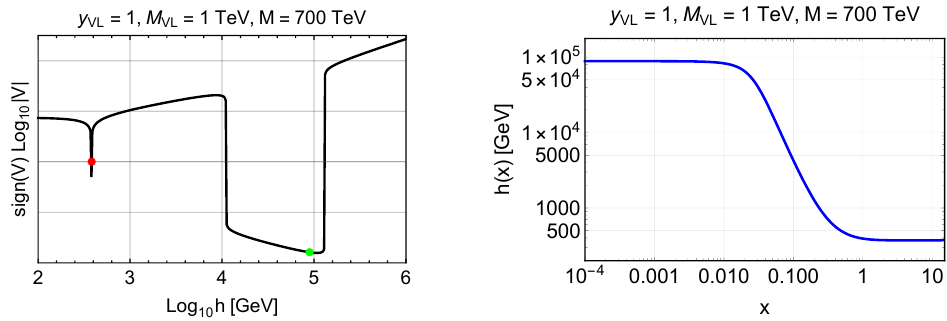
Figure 11 . Potential (left) with UV vacuum restored by a | H h | 6 /M 2 dimension-6 operator at a cut-off M = 700 TeV and the corresponding bounce solution (right) between the green and red points, calculated by solving numerically the Euclidean equation of motion for the Higgs field h as a function of the radial coordinate x , as described, e.g., in ref. [111]. The bounce action for this solution is S = 435 , corresponding to an exponentially suppressed probability for vacuum decay, B P ∼ e 404 − S B